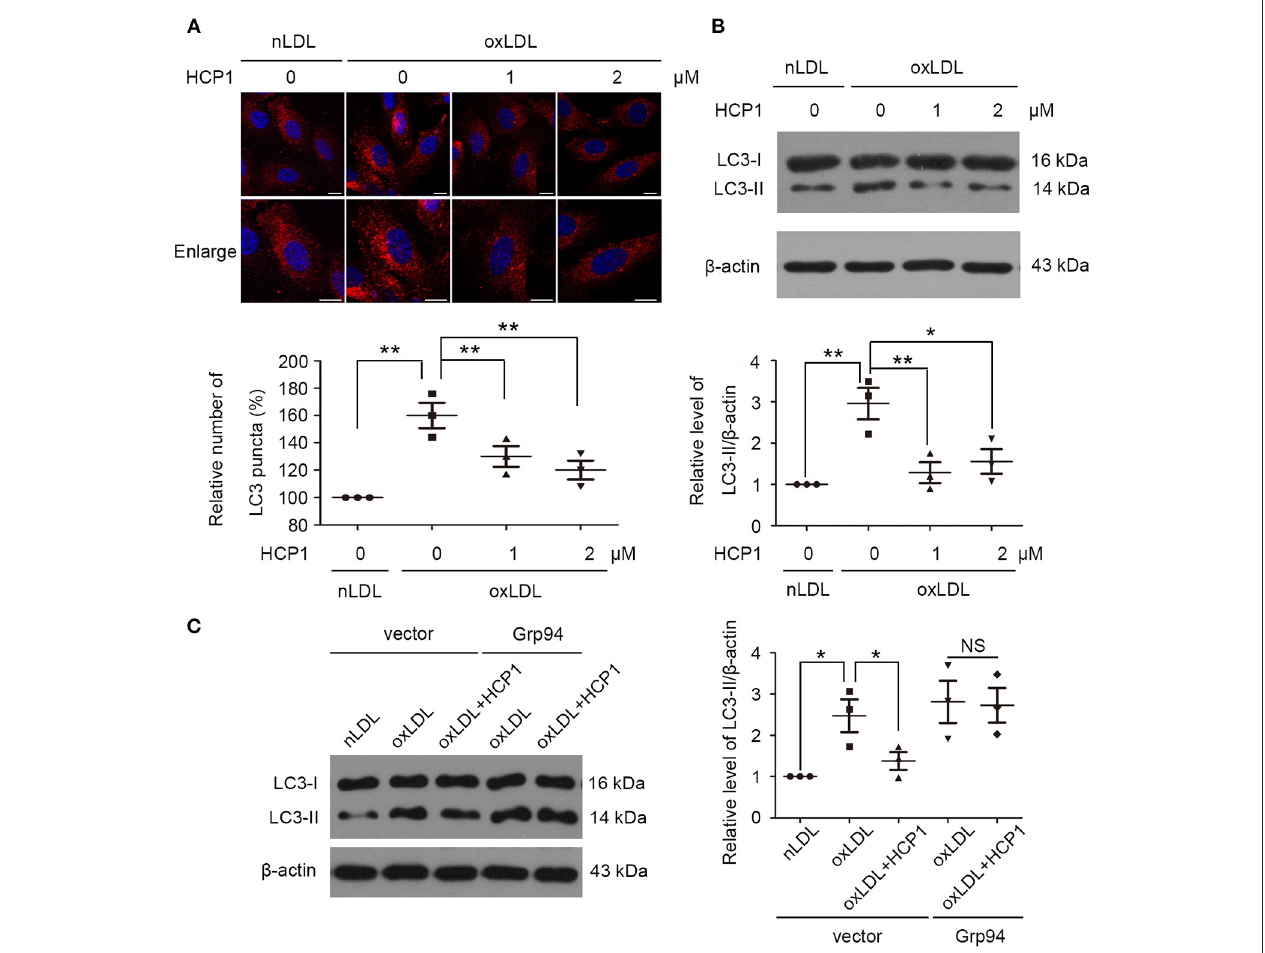
FIGURE 2 | HCP1 suppressed HUVEC autophagy induced by oxLDL. (A) Immunofluorescence staining of LC3 was performed after treatment with nLDL (50 µ g/ml), oxLDL (50 µ g/ml) with or without HCP1 (1, 2 µ M) for 12h in HUVECs. Bar charts show the quantification of average endogenous LC3 puncta per cell. Scale bar, 10 µ m. (B) Protein levels of LC3-II were detected after treatment with nLDL (50 µ g/ml), oxLDL (50 µ g/ml) with or without HCP1 (1, 2 µ M) for 12h in HUVECs. (C) Protein levels of LC3-II in HUVECs transfected with c-Myc empty vector or c-Myc-Grp94-wt plasmid for 24h were detected after treatment with nLDL (50 µ g/ml), oxLDL (50 µ g/ml) with or without HCP1 (1 µ M) for 12h. Data are mean ± SEM; * p < 0.05, ** p < 0.01, NS p > 0.05; n = 3. Statistical analyses were performed using one-way